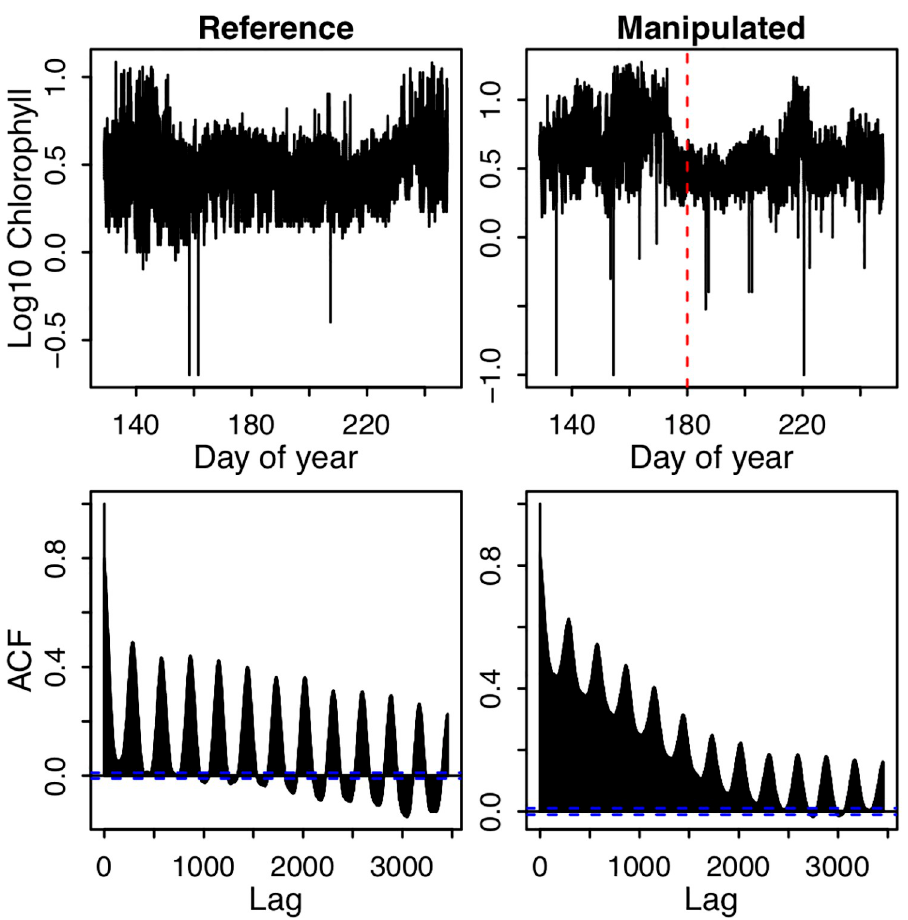
Fig 4. Time series and autocorrelation function of high frequency in situ chlorophyll fluorescence measurements in Peter Lake (manipulated) and Paul Lake (reference) in 2015. The red vertical dashed line indicates the day when fertilization was halted in Peter Lake. For the bottom panels, vertical bars are drawn from 0 to a height corresponding to the correlation, and the horizontal axis is the time lag of the correlation measured in time steps for the entire period of study. The horizontal blue dashed lines surround the (relatively narrow) region above or below which the values of autocorrelation are significant at α = 0.05. The time series resolution is five minutes, such that the correlation at a lag of 288 represents the autocorrelation at a daily time